Question: What type of chart is this?
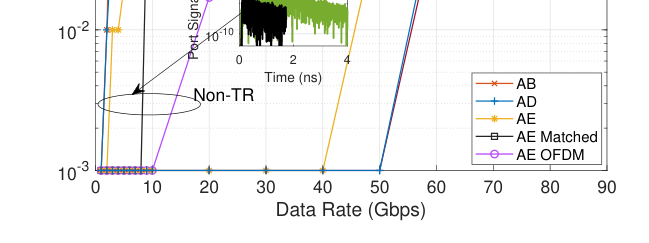
Answer: line